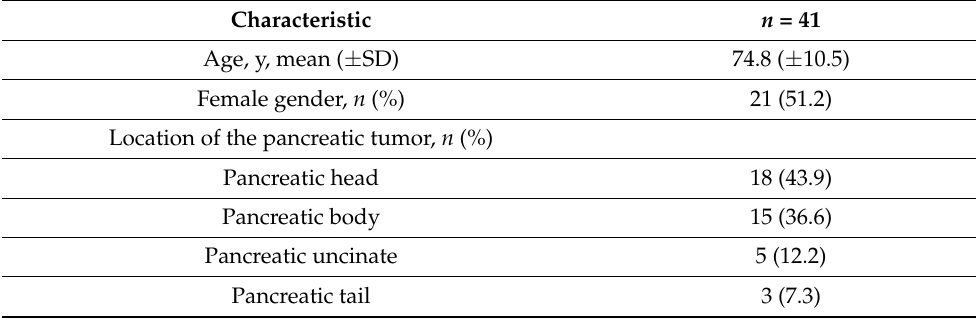
Table 1. Patient